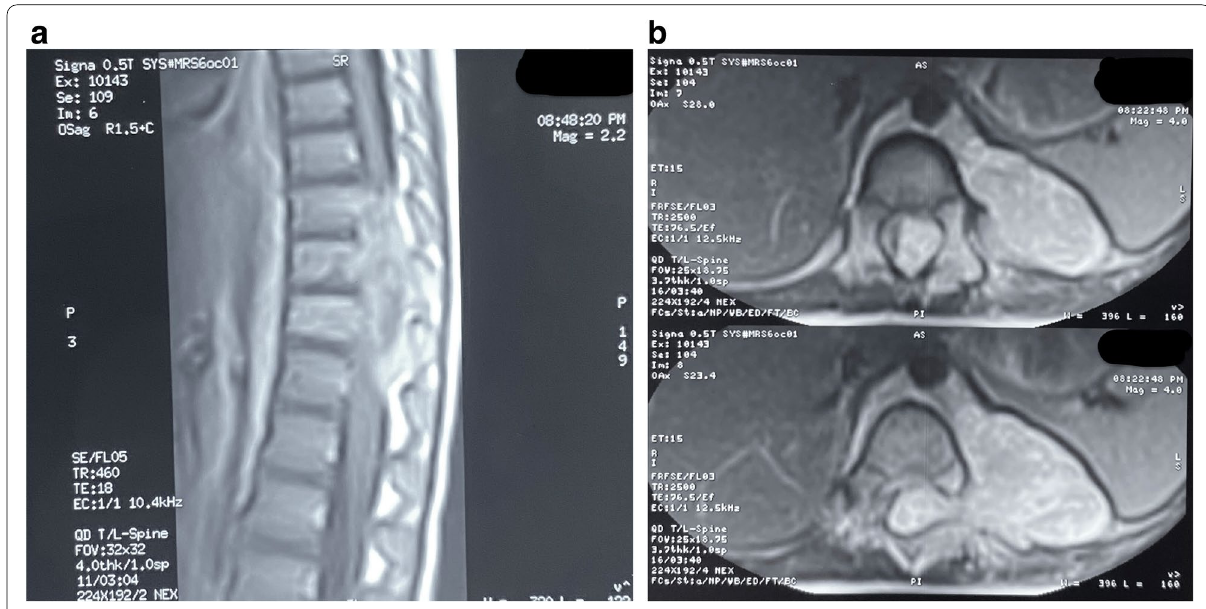
Fig. 1 a and b MRI of the mass. MRI showed a 4 3 2.5 cm retroperitoneal and paravertebral mass invading the diaphragmatic crus, the × × lateral neural foramen, and posterior paravertebral muscles. The tumor was surrounding the T10 vertebral body with intraspinal extension and compression of the spinal cord and bony erosion of the vertebral bodies of T10 and T11 on the left